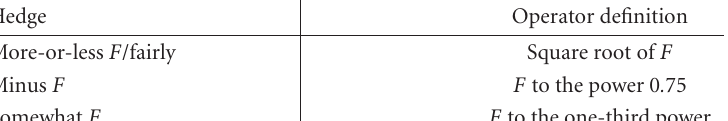
Table 2.2. Dilators.